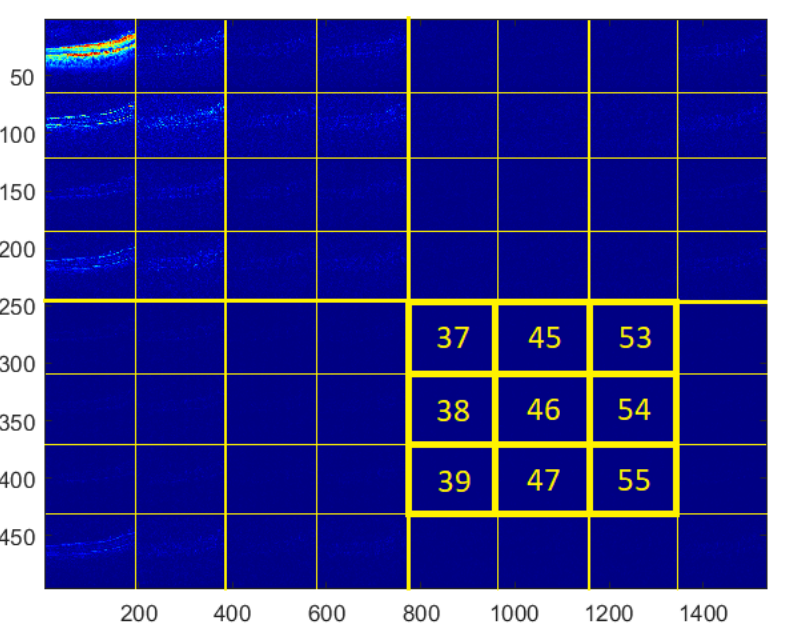
Figure 4. Blocks selected for data